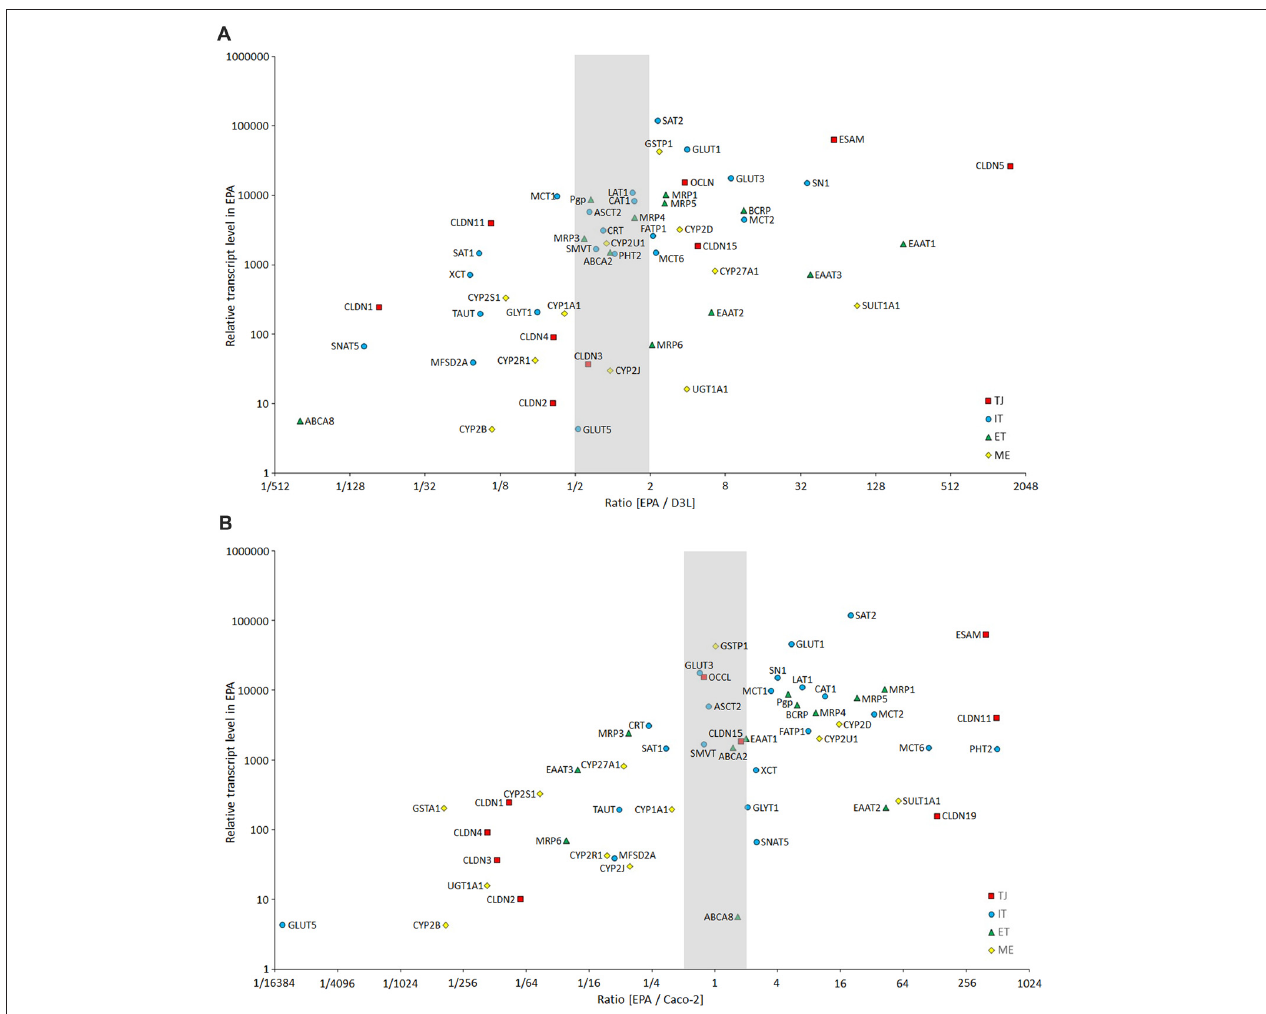
FIGURE 12 | Comparison of the expression of selected BBB genes between the primary rat brain endothelial cell-based EPA model and the human brain endothelial cell line D3 (A) , and the human intestinal cell line Caco-2 (B) measured by inventoried TaqMan Gene Expression Assays. The figure shows the ratio between the gene expression level of tight junction proteins (TJ, red square), influx transporters (IT, blue dot), efflux transporters (ET, green triangle) and selected metabolic enzymes (ME, yellow diamond) in EPA and D3 or Caco-2 cells. The graph also displays the expression values in the EPA sample on the y-axis to demonstrate the level of expression of studied